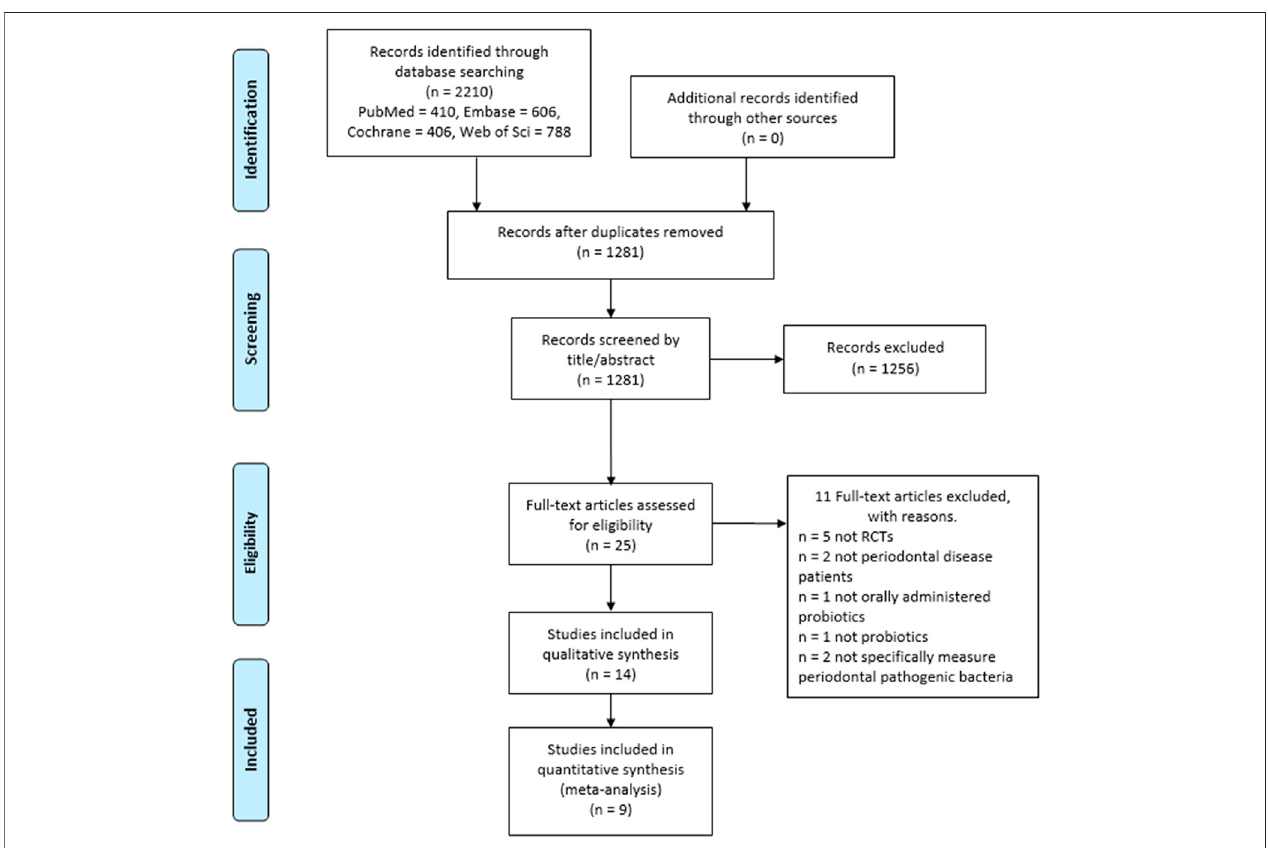
FIGURE 1 | PRISMA fl owchart presents the process of study selection.